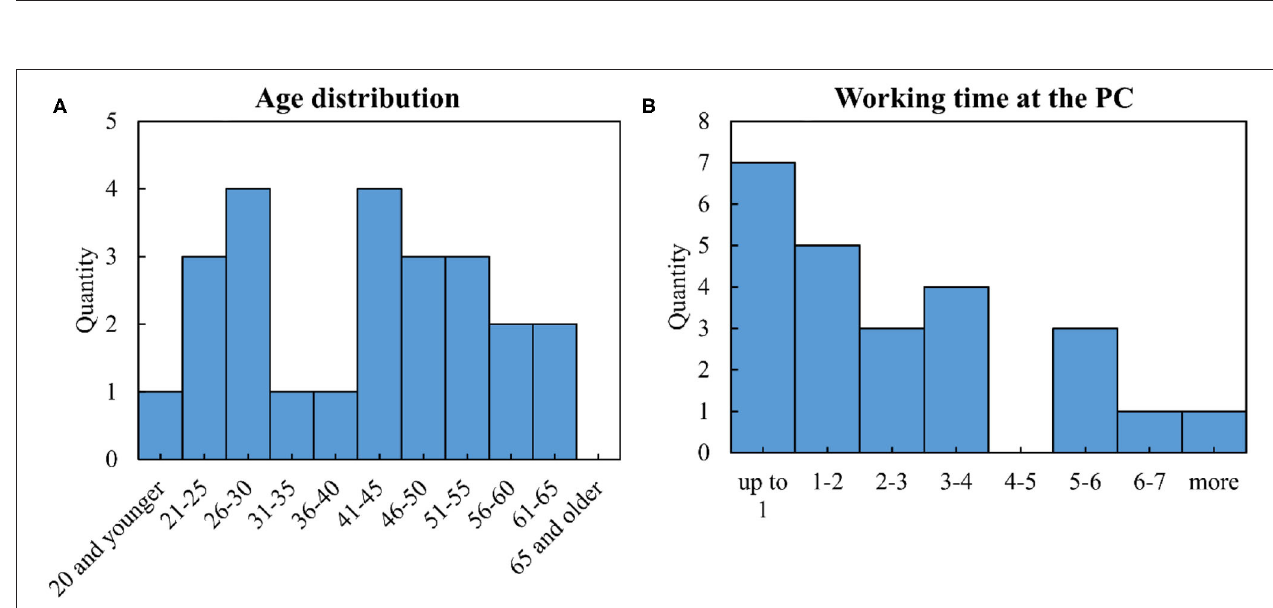
FIGURE 6 | Characteristics of the subjects: (A) age distribution, (B) working time at the PC.